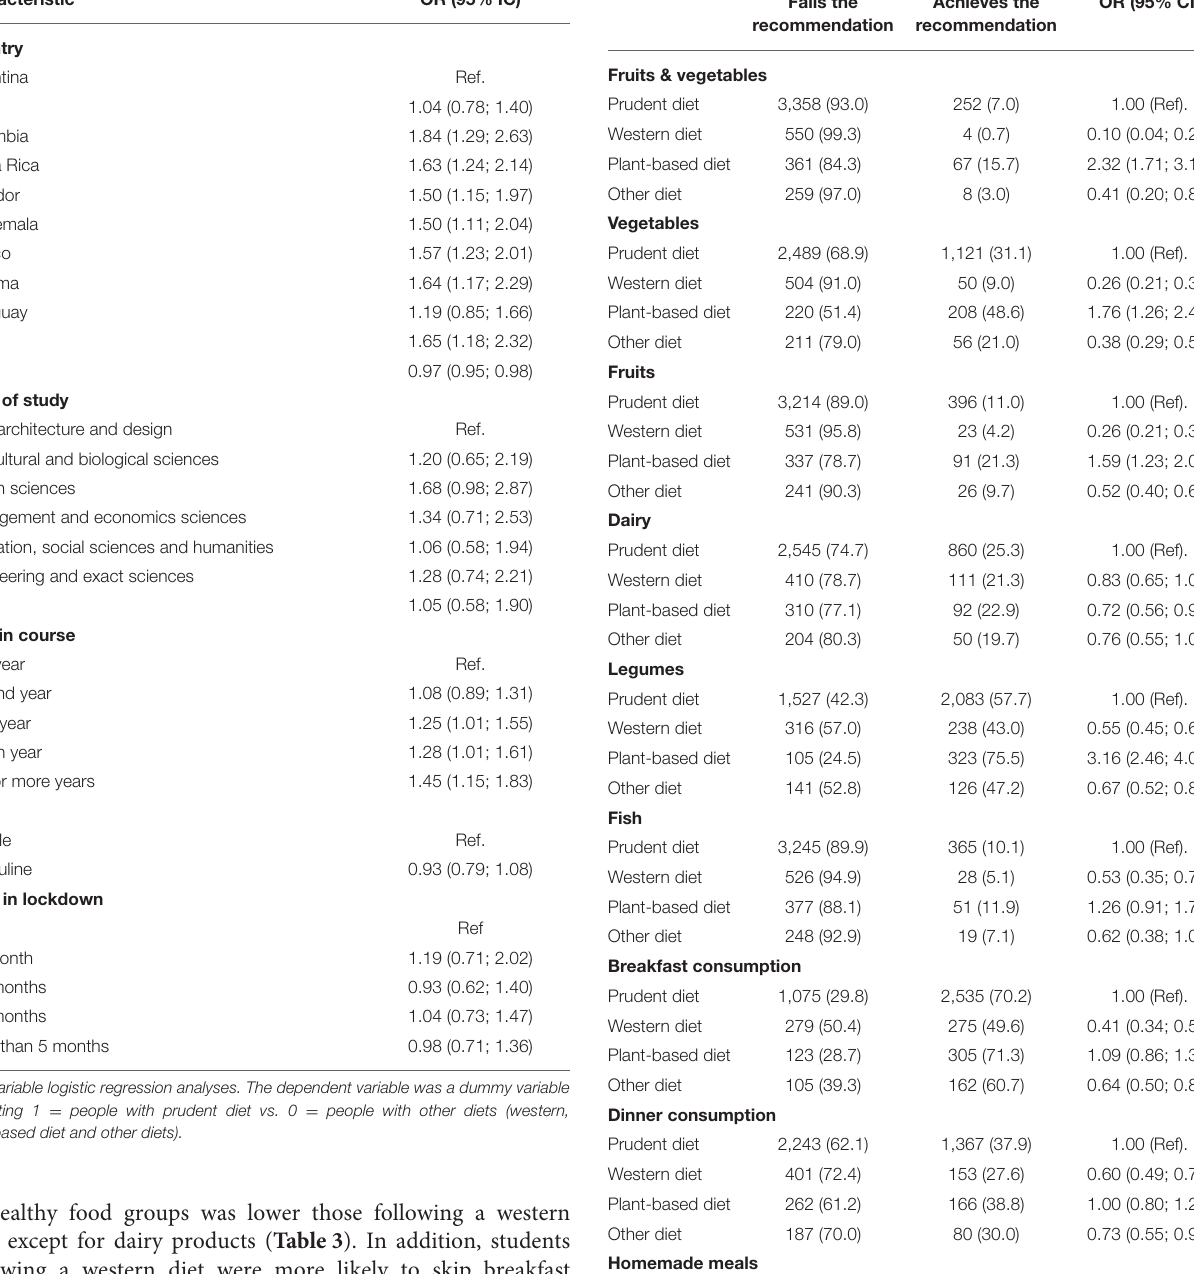
TABLE 3 | Achievement of healthy food group recommendations among dietary patterns. Fails the